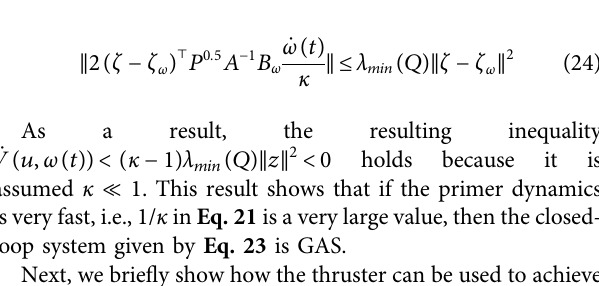
Frontiers in Robotics and AI |